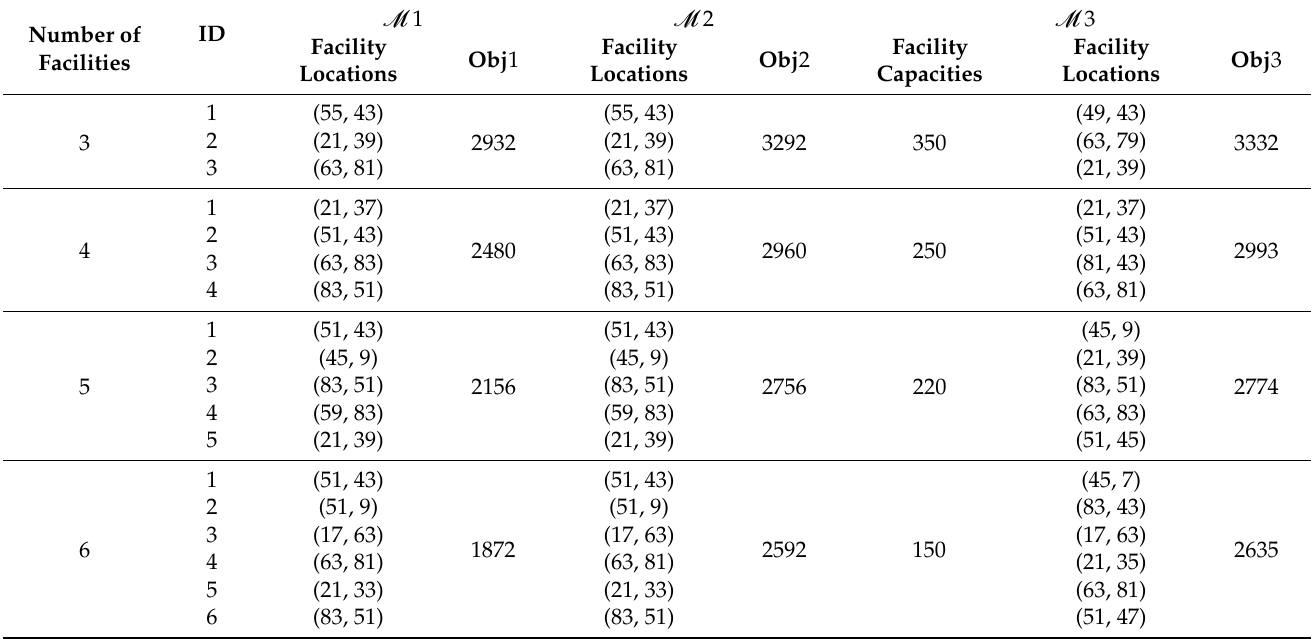
Figure 12. Cross-validation of m and F on the total cost while c = 0.25. ( a ) Instance 24; ( b ) Instance 25. ( c ) Instance 26; ( d ) Instance 27. Table 5. Comparison of optimal solutions and objective function values among three